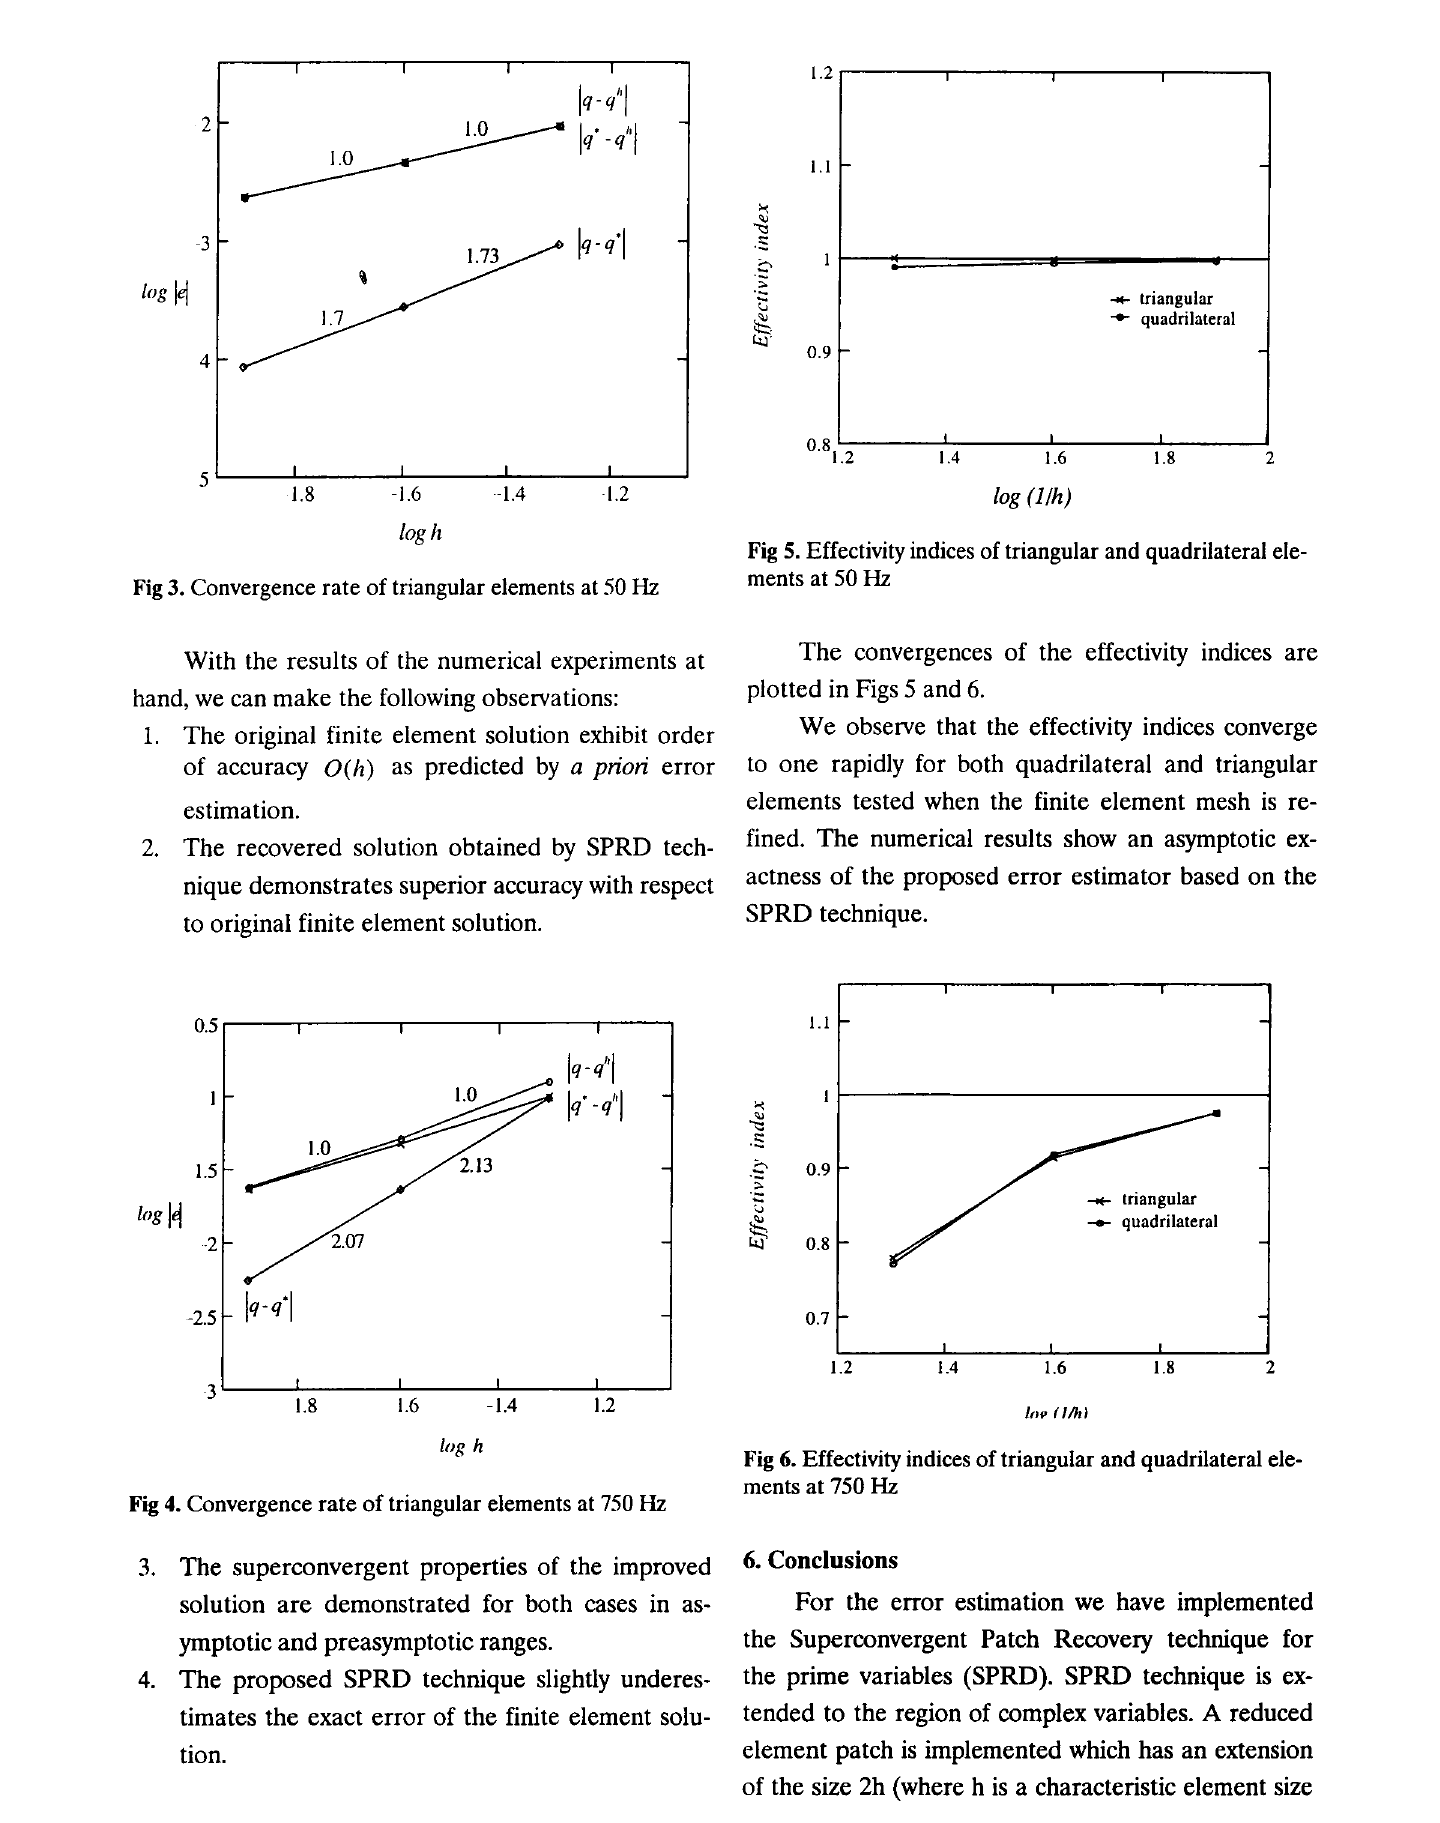
Fig 4. Convergence rate of triangular elements at 750 Hz